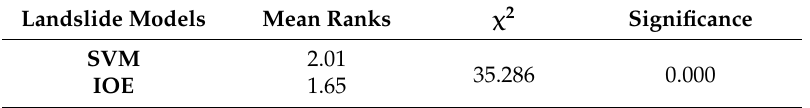
Table 6. Average ranking of the two landslide susceptibility models using the Friedman